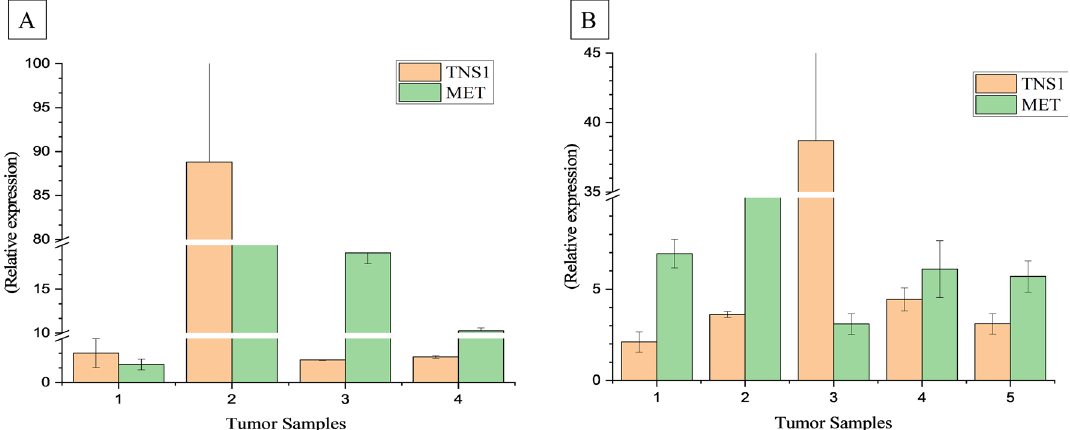
Figure 7. Differential expression analysis of TNS1 and MET gene on EOCRC. ( A ) Represents the relative expression analysis 4 tumor samples of the discovery cohort and ( B ) Represents the relative expression analysis of TNS1 and MET gene on validation